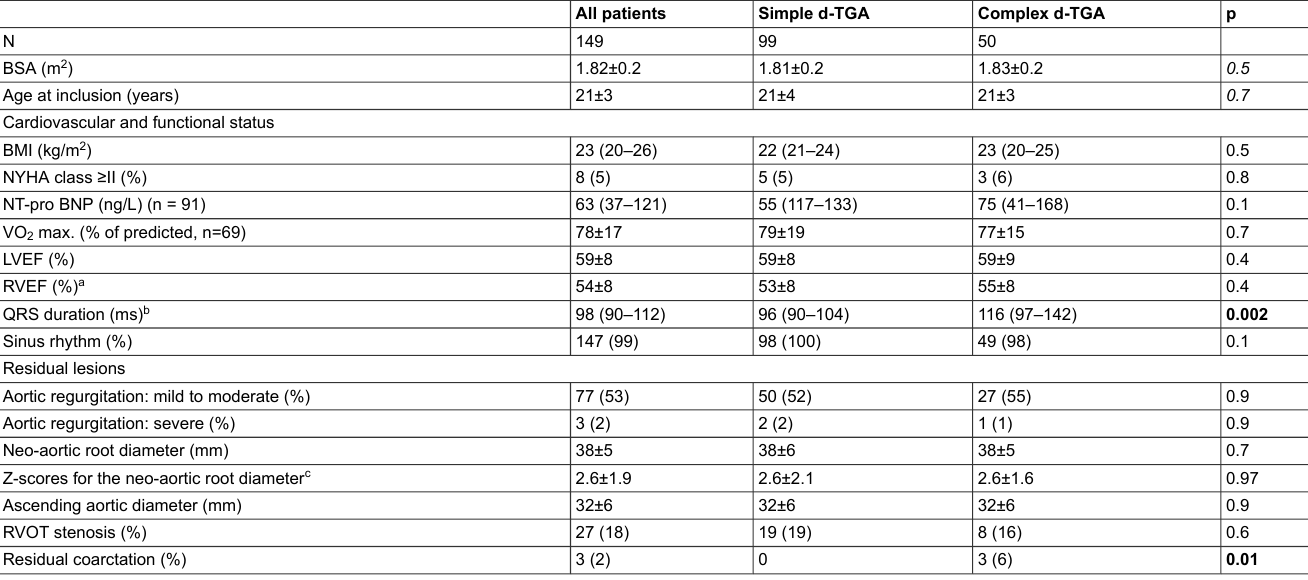
Table 2: Functional status and residual lesions at the time of inclusion (adult cohort).